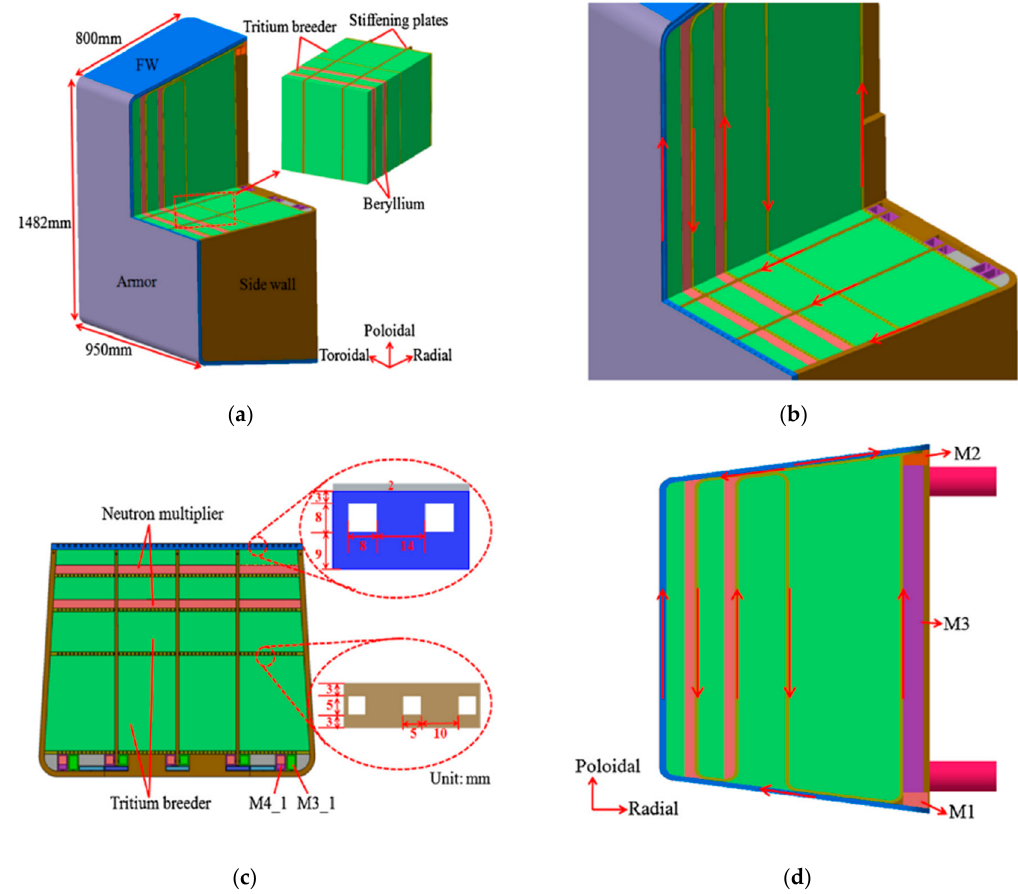
Figure 10. The structure of the typical Water-Cooled Ceramic Breeder (WCCB) blanket: ( a ) Explosive view of the WCCB blanket; ( b ) Partially enlarged schematic; ( c ) Toroidal cross-section; ( d ) Poloidal cross-section. Table 5. Main parts dimensions of the WCCB blanket #3 module. Items Blanket size